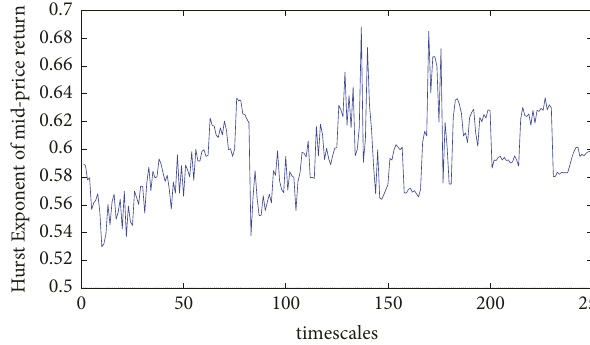
Figure 14: Hurst exponent of mid-price